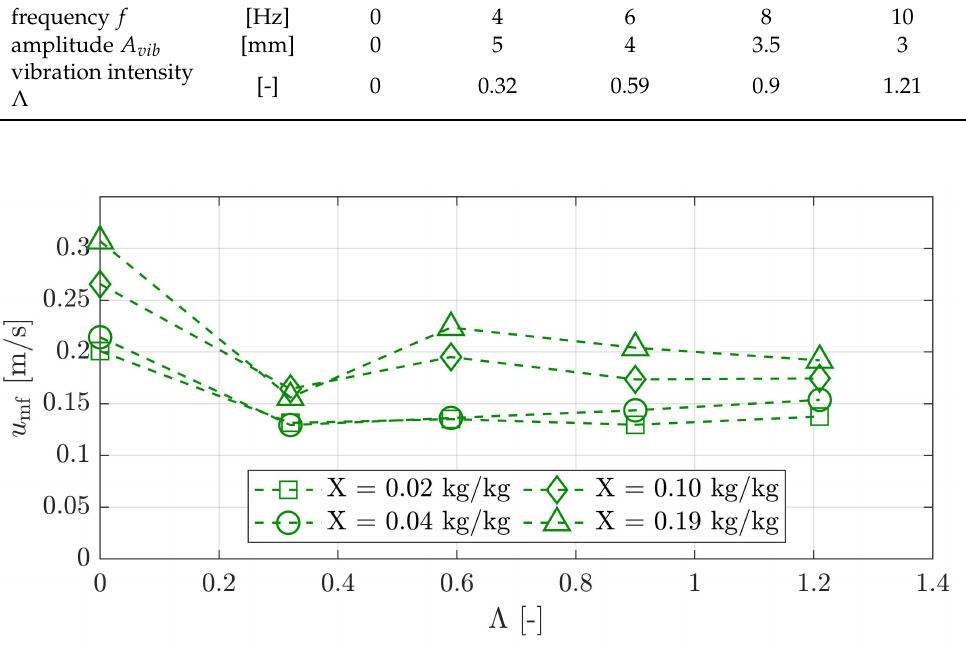
Figure A2. Minimum fluidization velocity ( u mf ) of Cellets against vibration intensity Λ for varied particle moisture